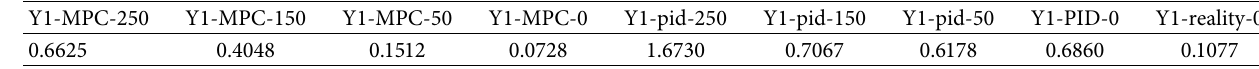
Table 1: Error variance (cm 2 ) under different